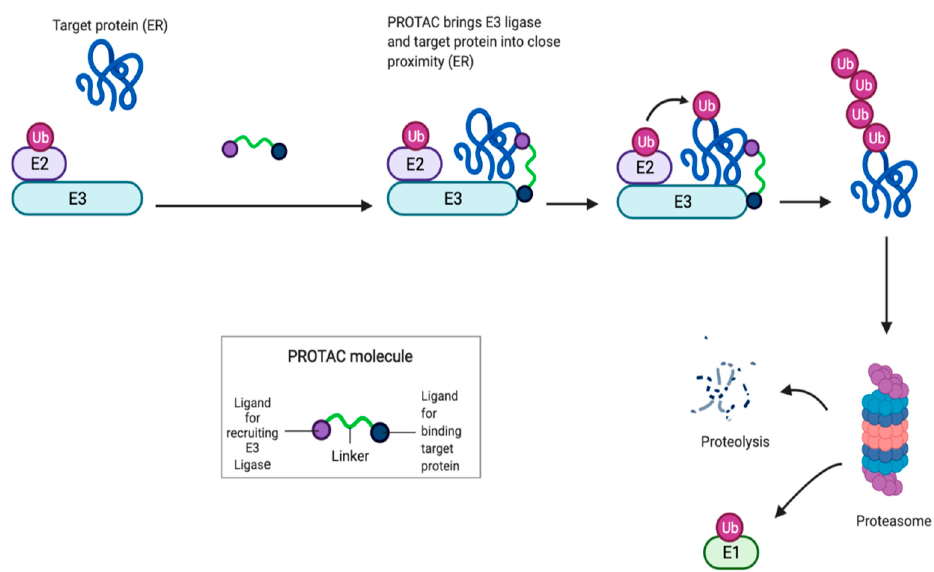
Figure 4. PROTACs: proteolysis targeting chimeras are heterobifunctional molecules made up of a ligand for ER (target protein) and another ligand, serving as the E3 ubiquitin ligase complex substrate. Once PROTACs bind to ER, recruit the E3 ubiquitin ligase complex, leading to a polyubiquitilation of ER ending on a proteasomal